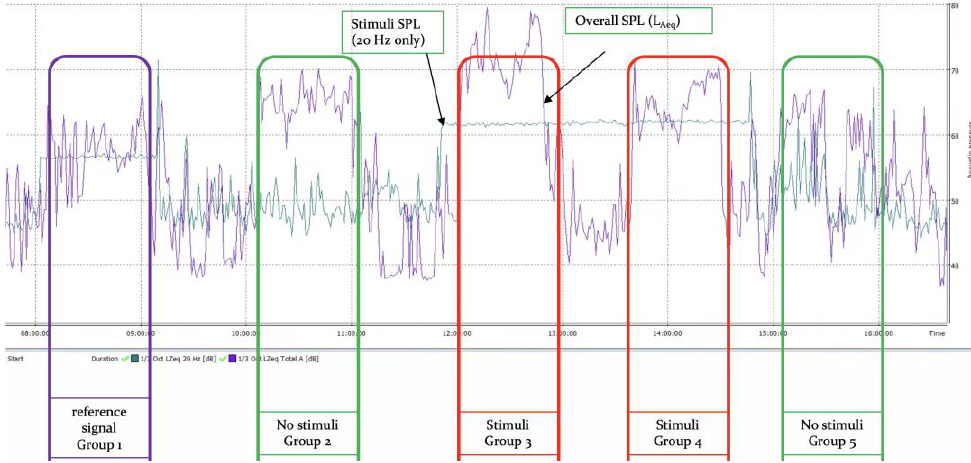
Figure 3. Level of stimuli and acoustic background monitoring during a sample day of the experi- ment.